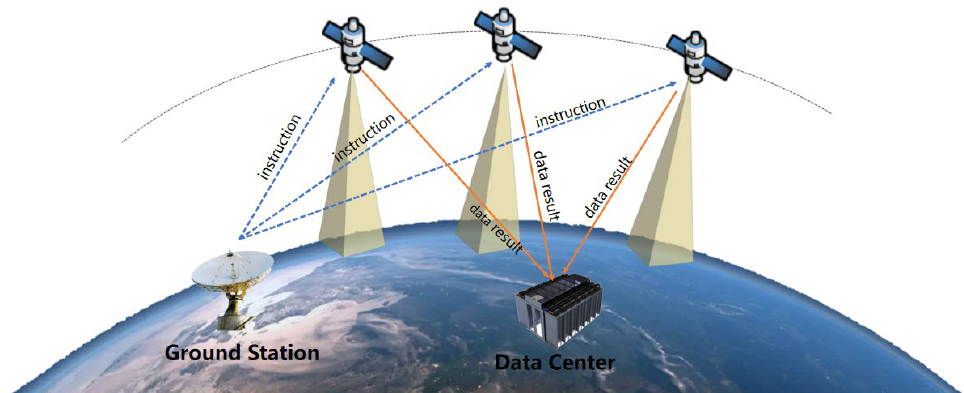
Figure 1. The traditional satellite computation fashion, where single-satellite calculation is the common mode. The ground station transmits instructions, the satellite calculates itself, and then the satellite sends the result back to the data center.